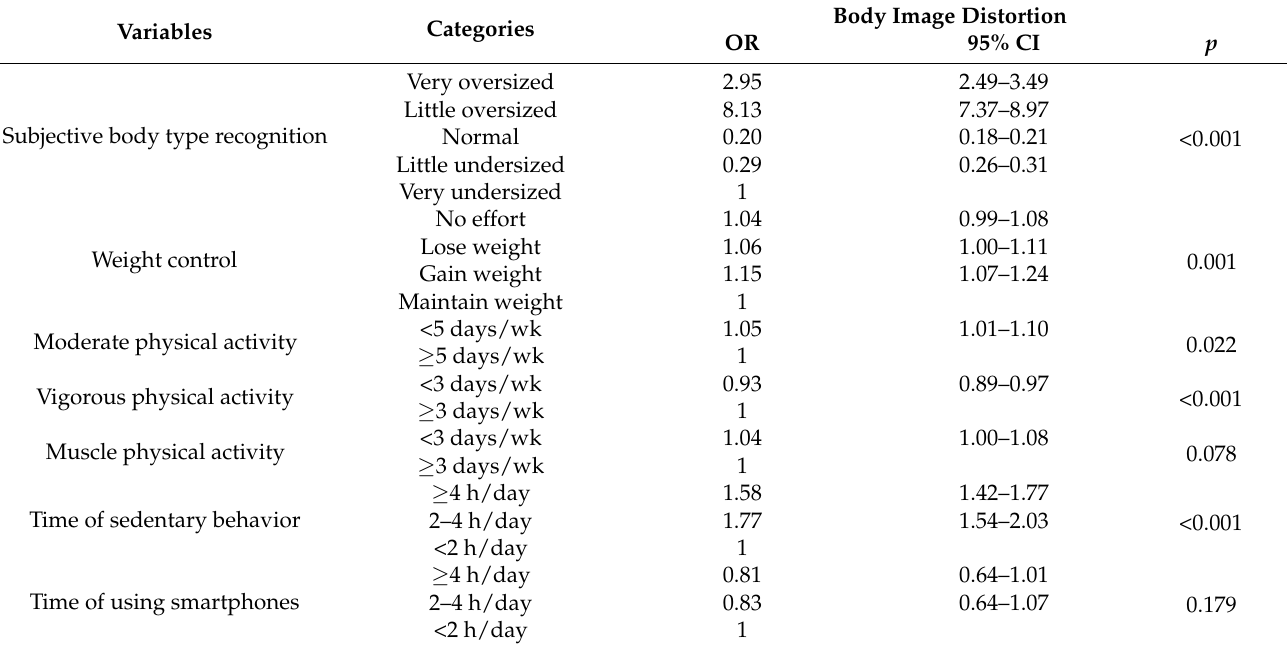
Table 5. Multivariate multinomial logistic regression analysis of the factors influencing body image